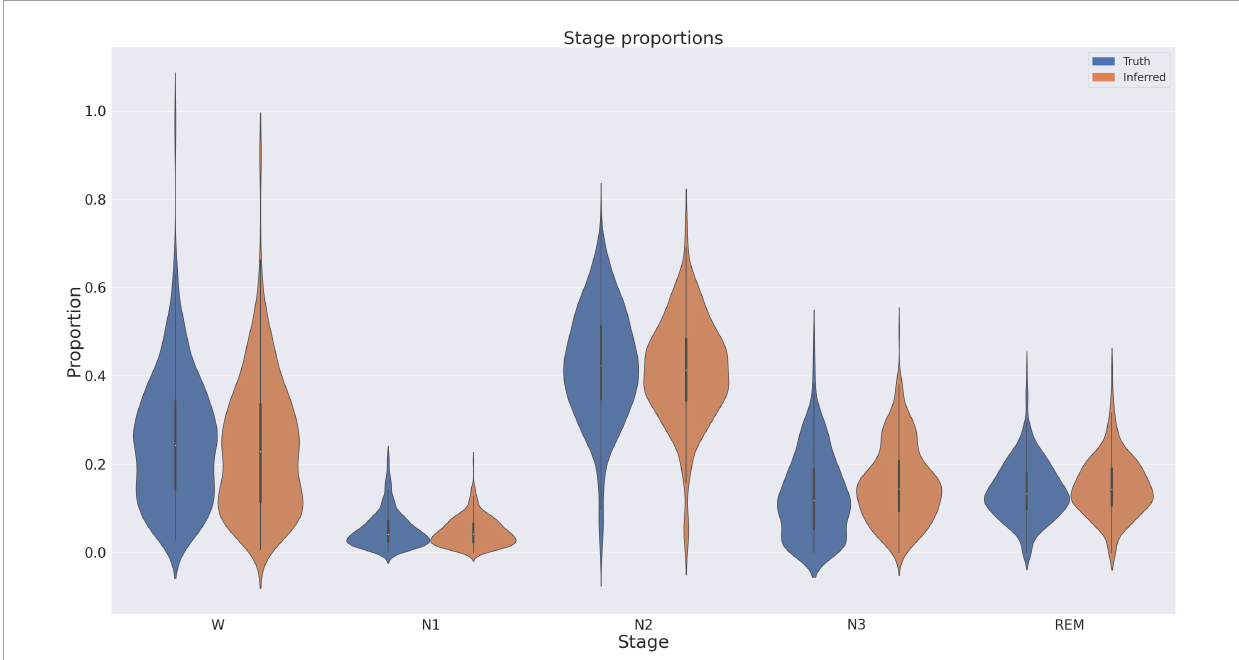
FIGURE5 Proportions of stages in ground truth versus those inferred by the Greifswald Sleep Stage Classifier (GSSC). There is a slight bias of the GSSC toward N3.